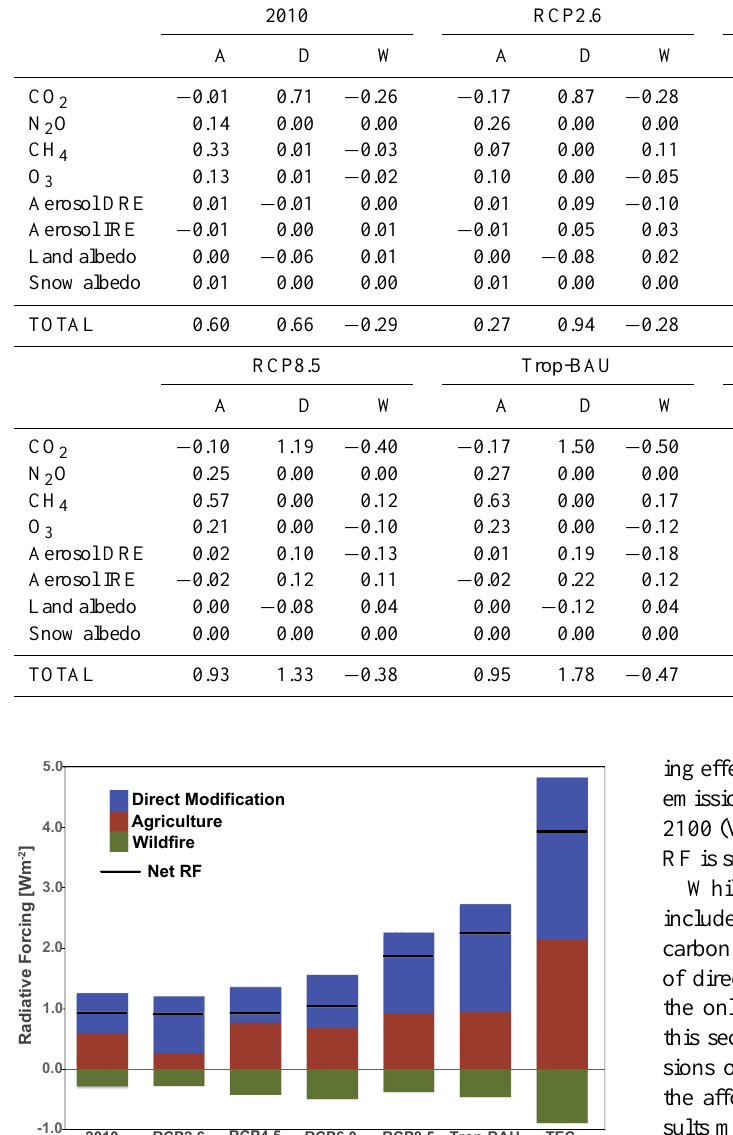
Land albedo Snow albedo